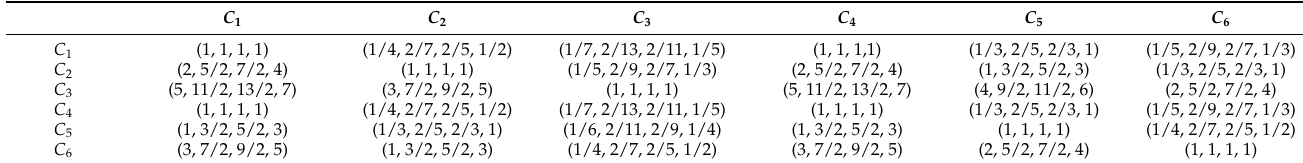
Table A1. Pair-wise comparison matrix of the